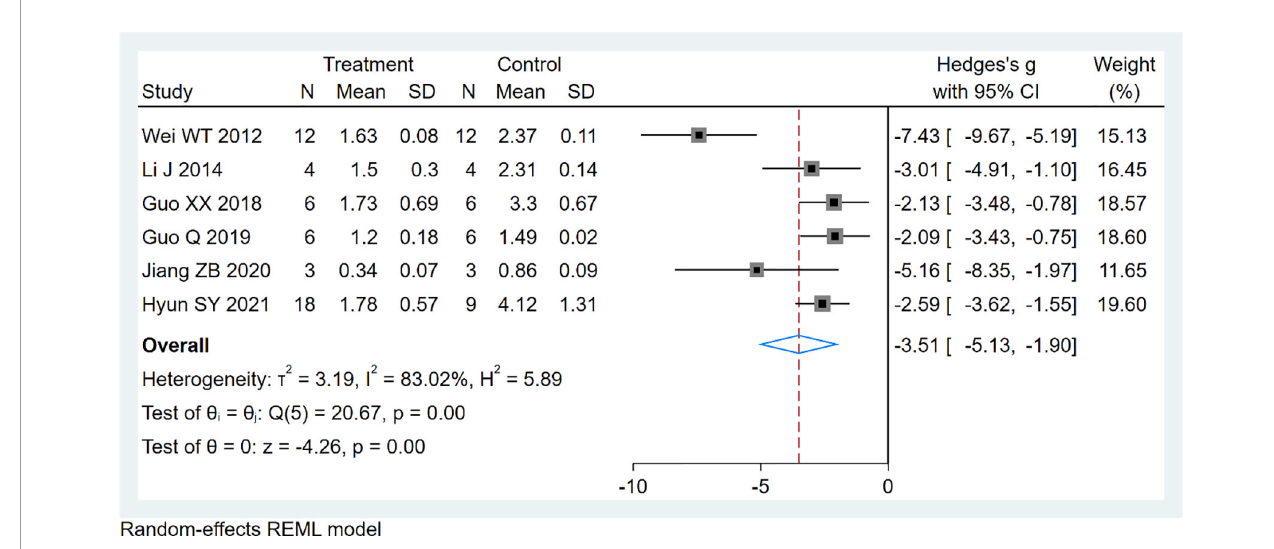
FIGURE 5 | Forest plot of tumor weight.